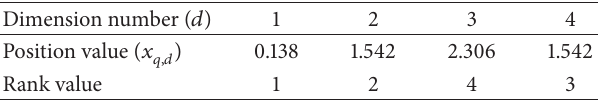
Table 1: Example of the mapping between the position of the particle and the permutation of